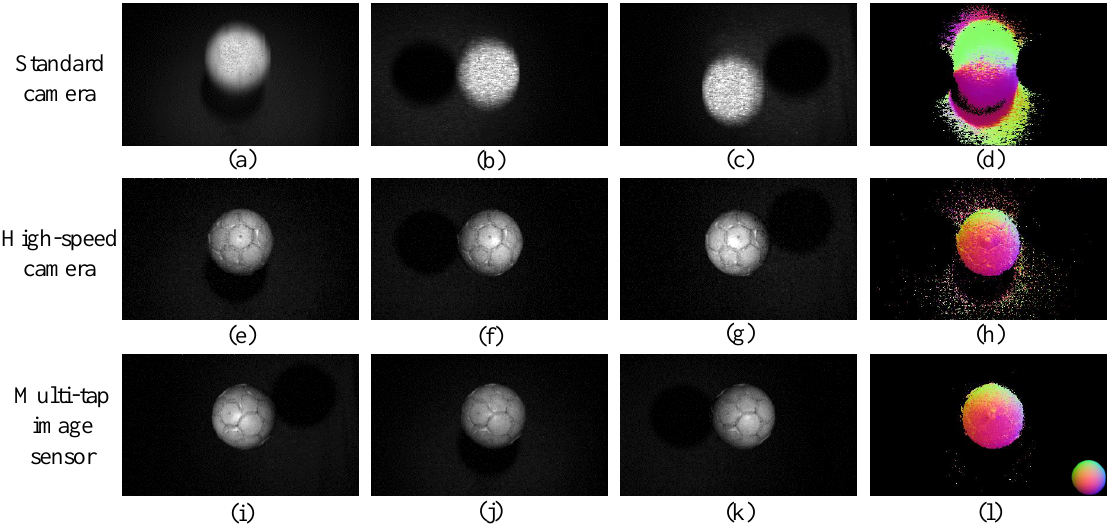
Figure 10. Results of estimation of surface normals of a dynamic scene composed of a falling ball. ( a – c ) show images captured with the standard camera settings and ( d ) is the resulting normal map. ( e – g ) show images captured using the high-speed camera settings and ( h ) is the resulting normal map. ( i – k ) show images captured using the multi-tap CMOS image sensor and ( l ) is the resulting normal map. To make the results easier to see, we modulated the brightness of the captured images to make